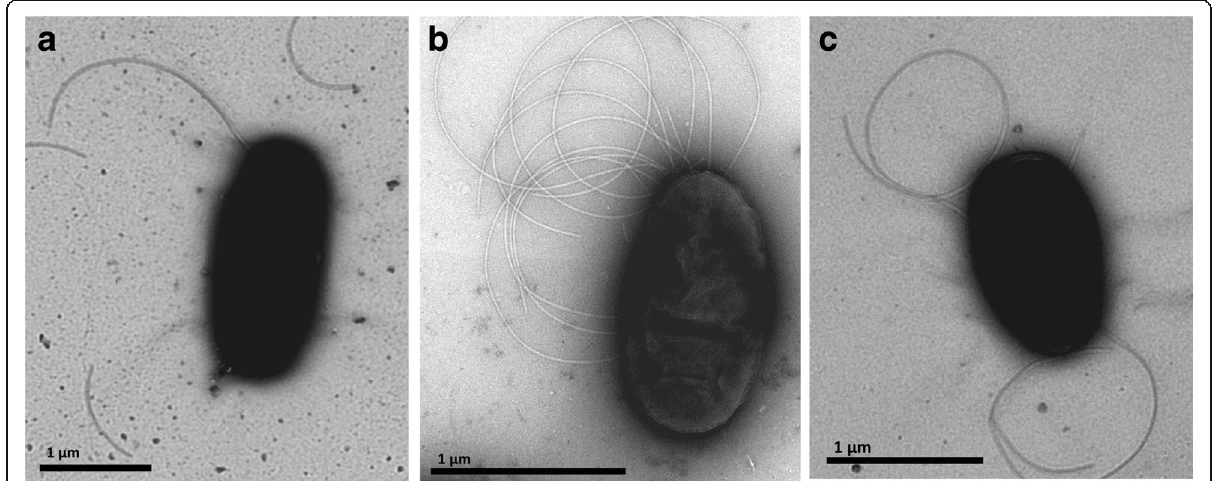
Fig. 2 Transmission electron microscopy of ( a ) Paraburkholderia terrae strain BS110, ( b ) P. terrae strain BS007, and ( c ) P. terrae strain BS437. The scale bars represent 1 μ